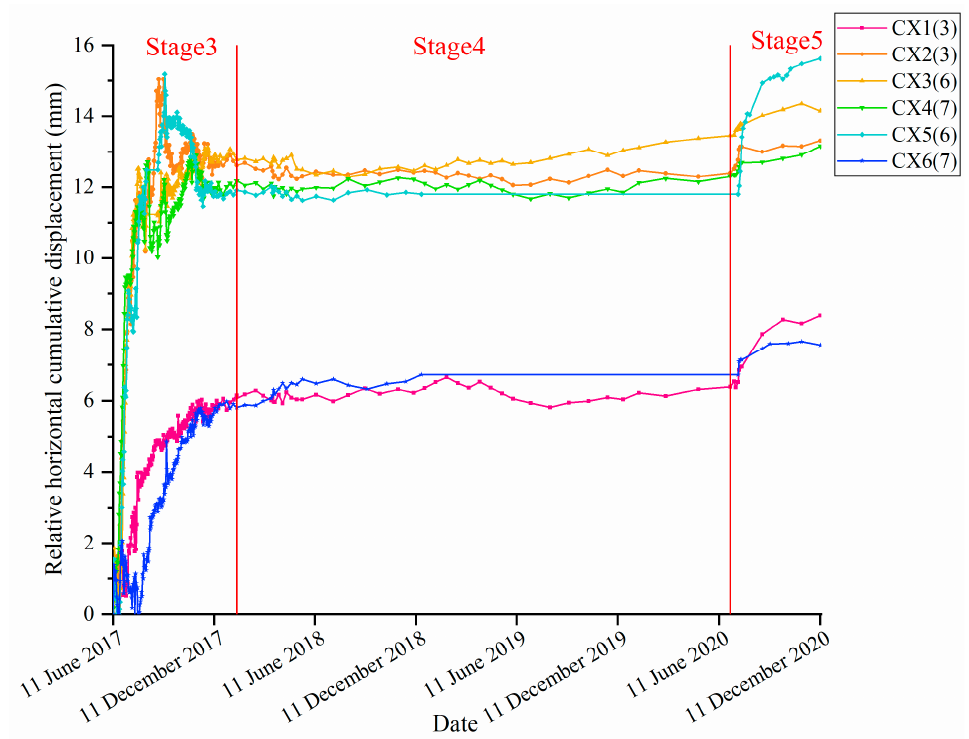
Figure 16. Detailed horizontal displacement deformation data of the maximum displacement depth of each deep horizontal displacement monitoring point. (Since the displacement values of CX5 and CX6 monitoring points from 11 August 2018 to 21 December 2018 are very small and close to stability, the two monitoring points did not continue monitoring from 21 December 2018 to 16 July 2020).